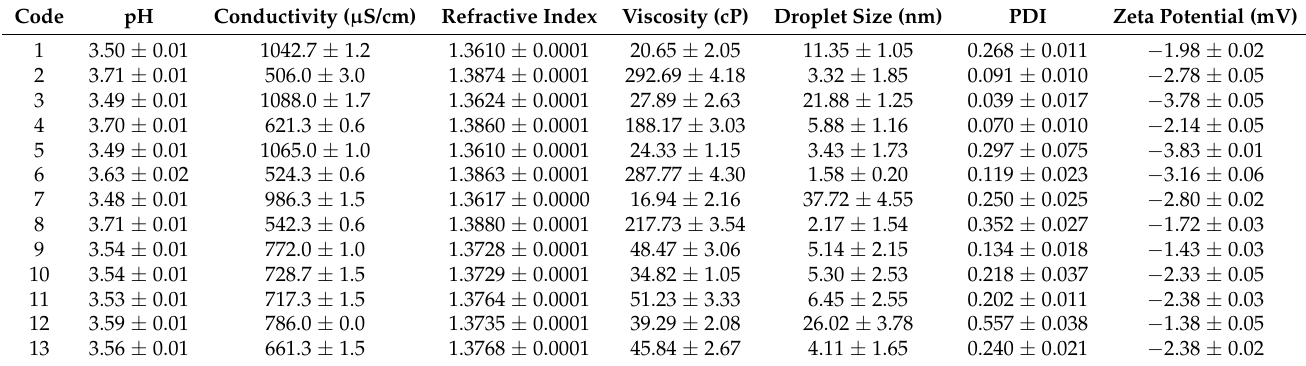
Table 4. Results of pH, conductivity, refractive index, viscosity, and particle characteristics determined at 25 ± 0.5 ◦ C, which describe the physical character of MELSA 1–MELSA 13